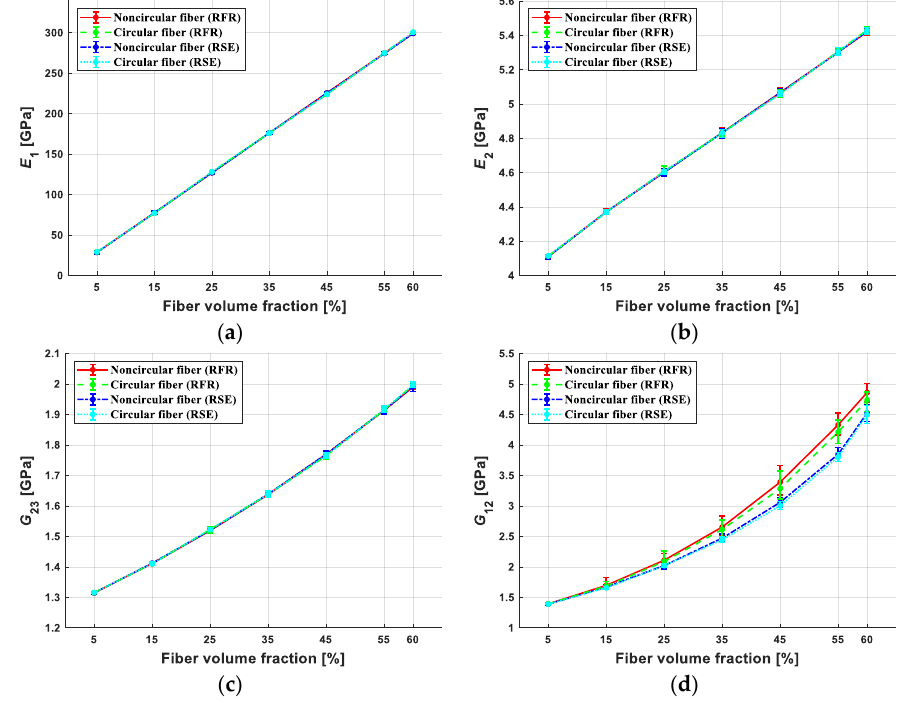
Figure 7. Effective elastic properties: ( a ) E 1 , ( b ) E 2 , ( c ) G 23 , and ( d ) G 12 of M55J / M18, with V f ranging from 5% to 60%.